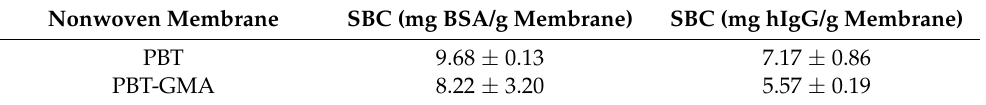
Table 2. Static Binding Capacity (SBC) of unmodified PBT, and PBT-GMA grafted membranes. Nonwoven